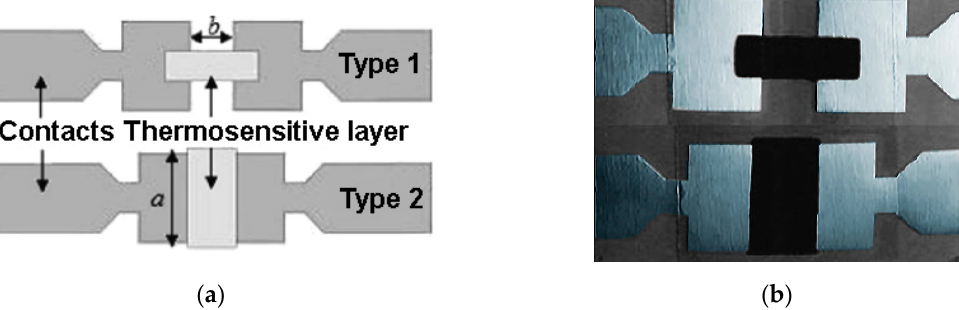
Figure 8. Schematic ( a ) and optical image ( b ) of the sensors structure obtained by printing [35]. A linear negative characteristic of resistance variation with temperature was observed in all situations (Figure 9), with a TCR of approx. 2-times higher in the case of sensors with 1 wt % CNTs, without any noticeable influence after the bending of the sensitive element.